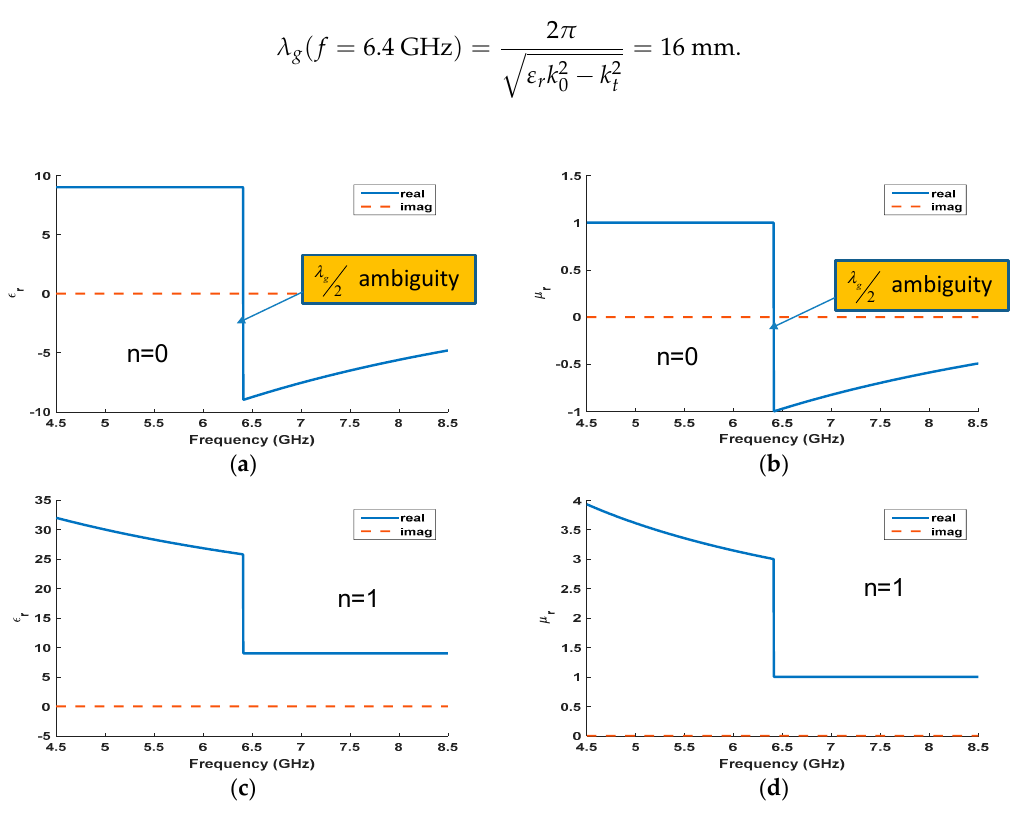
Figure 4. Estimated electric permittivity and magnetic permeability for a dielectric sample of 8 mm with ε r = 9 − j0, µ r = 1 − j0 in the case of n = 0 ( a , b ) and n = 1 ( c , d ).